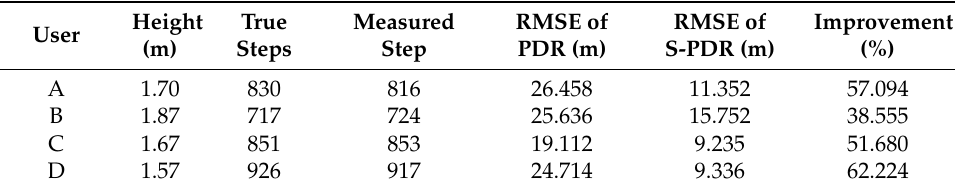
Table 12. The accuracy analysis of trajectories using the